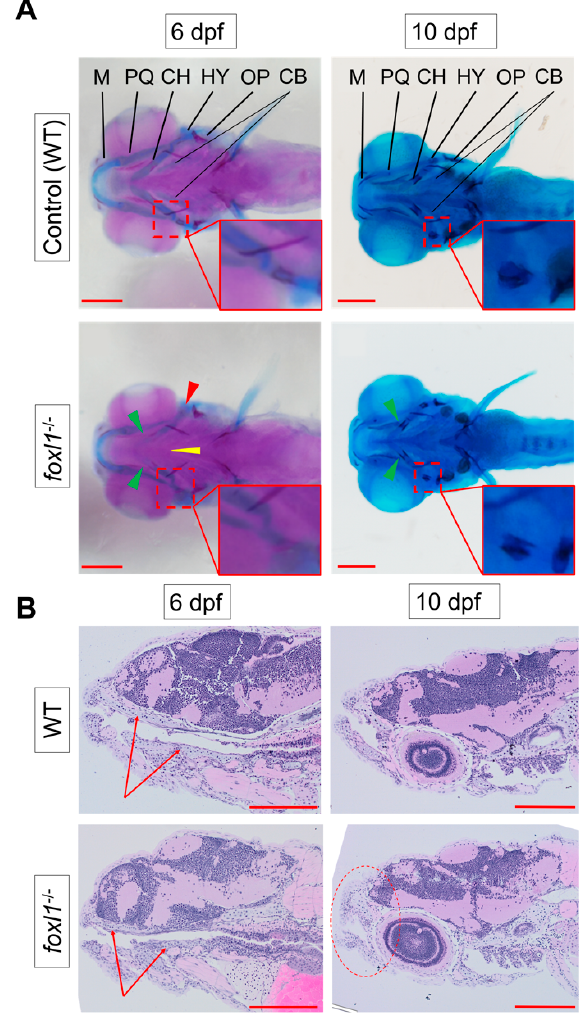
Figure 1. Reduction in cartilage in foxl1 mutants. ( A ) Alcian blue (staining cartilage) of WT and foxl1 -/- (6 dpf n = 24, 10 dpf n = 20) embryos, indicating a delay in ceratohyal cartilages at 6 dpf (green arrowhead), but a recovery begins by 10 dpf. Alizarin red indicates a delay in the ossification of the hyomandibula (red arrowhead and inserts) in foxl1 mutants at 6 dpf, which also begins to normalize by 10 dpf. ( B ) Longitudinal sections through jaw, demonstrating a reduced presence of cartilage formation in the upper and lower jaw as indicated by the red arrows at 6 dpf, along with a shortened and round jaw structure that progresses by 10 dpf (red circle). PQ, palatoquadrate; M, Meckel; HY, hyomandibula (hyosympletic); CH, ceratohyal; CB, ceratobranchials (yellow arrowhead); OP, operculum. Zoomed-in inserts in each panel focus on the cartilage and primary centres of ossification of the hyomandibula. Scale bars are 200 µm.